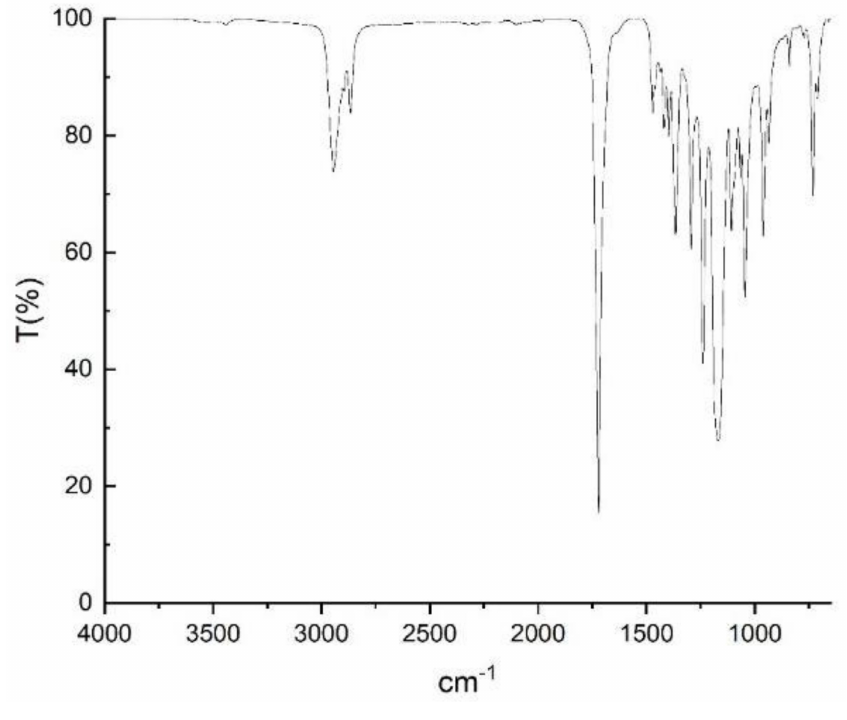
Figure A3. FTIR spectrum of